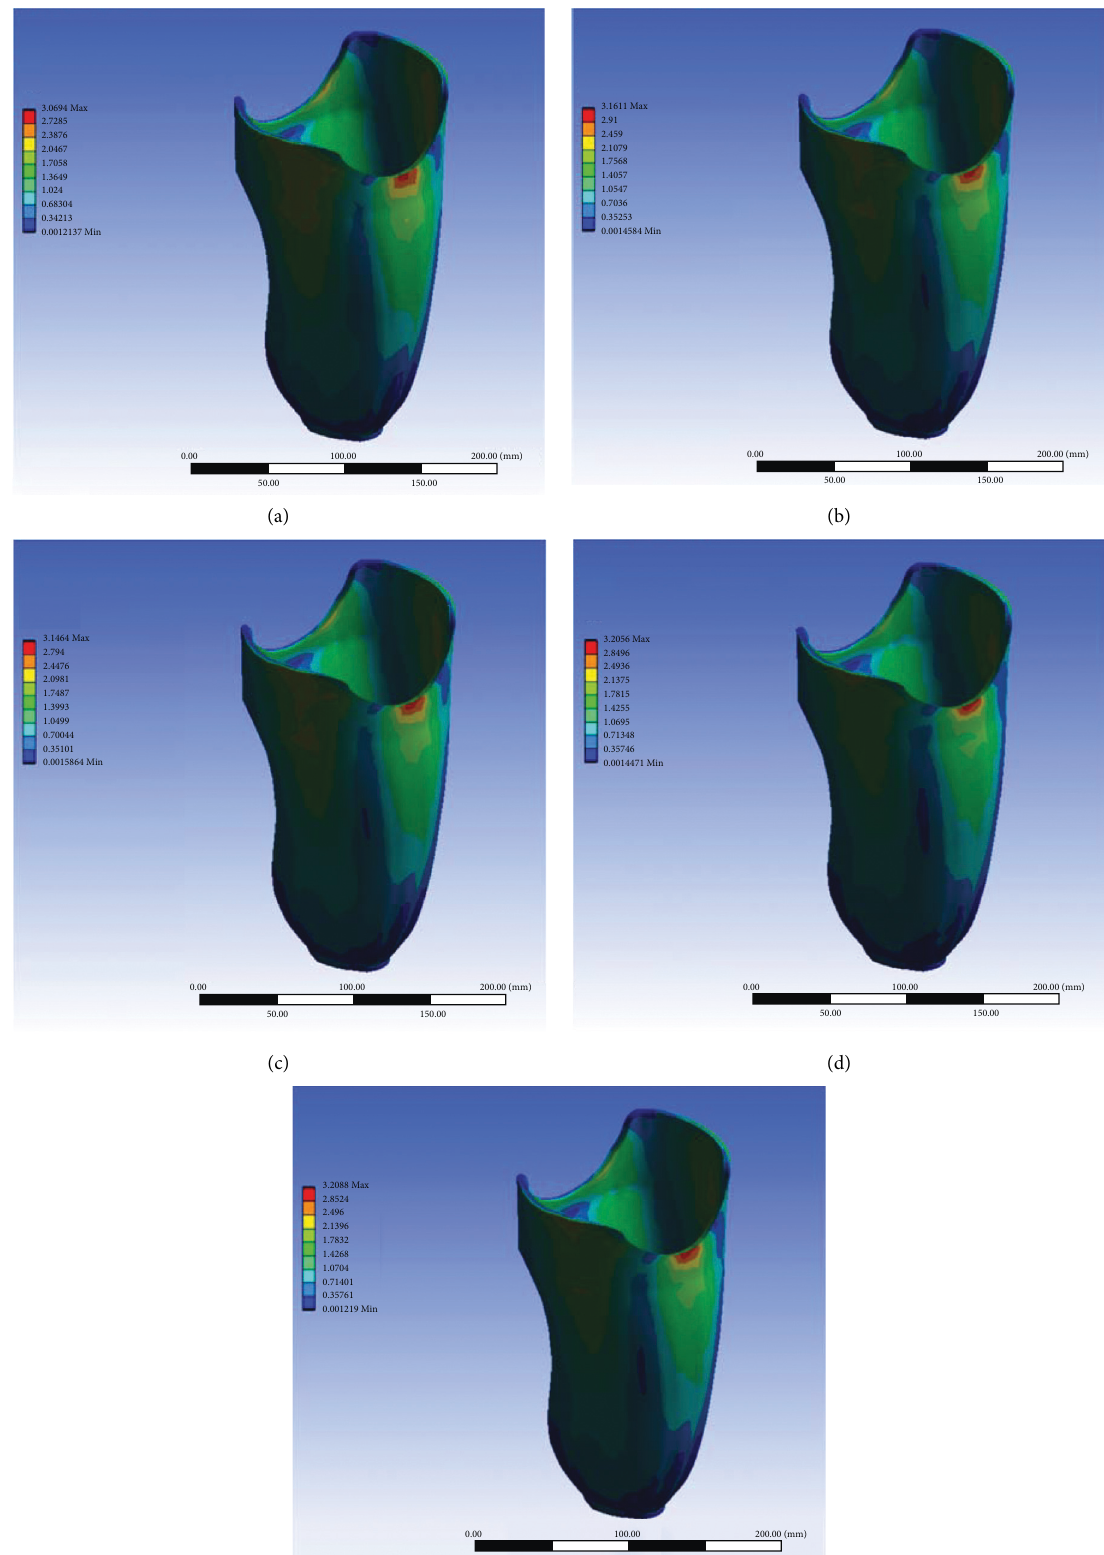
Figure 7: Contours of stress distribution of (a) pristine biobased epoxy, (b) FF/biobased epoxy composite, (c) FF/1wt % SS/biobased epoxy composite, (d) FF/3wt % SS/biobased epoxy composite, and (e) FF/5wt % SS/biobased epoxy